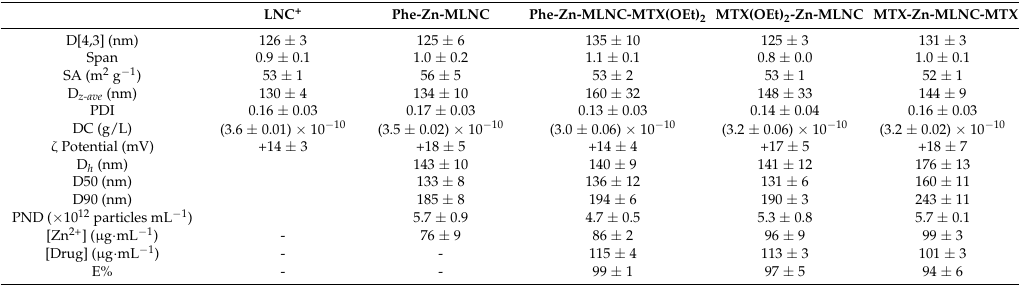
Table 1. Physicochemical characterization of LNC + , Phe-Zn-MLNC, Phe-Zn-MLNC-MTX(OEt) 2 ,